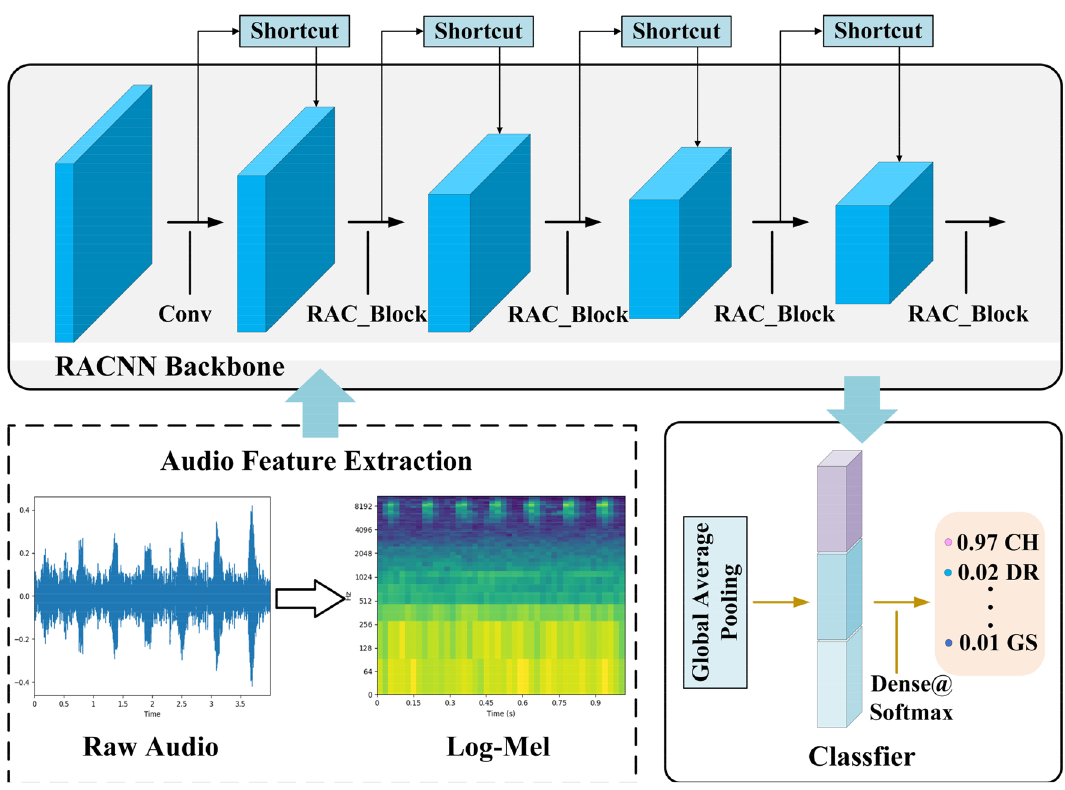
Figure 5. The forward propagation process of the RACNN